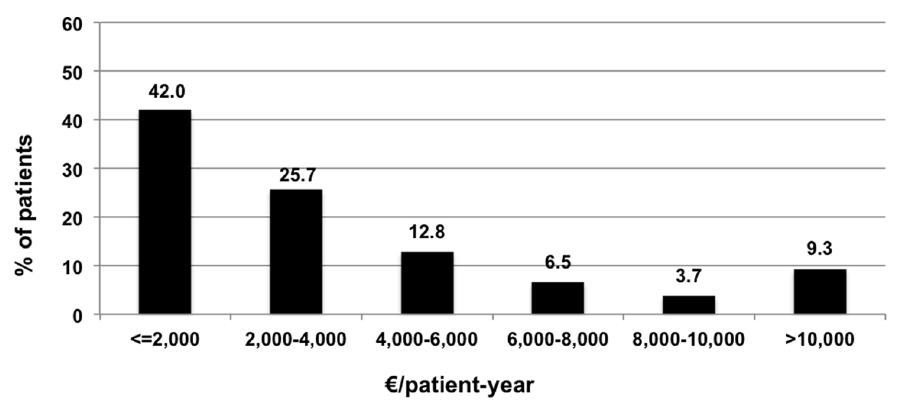
Figure 1. Patient distribution of mean healthcare costs ( J /patient-year).